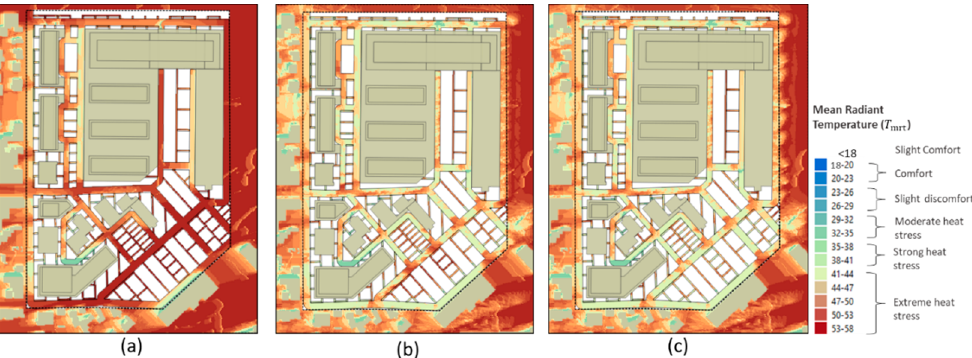
Figure 13. The overlaid map of the alternative pathway and the mean Tmrt for the hottest period of days (12:00–19:00) with the classification of PET in three conditions; ( a ) the baseline map without tree planting scenario; ( b ) the first level of tree placement with the priority of pathways; ( c ) the second level of tree placement with the priority of some urban spaces.